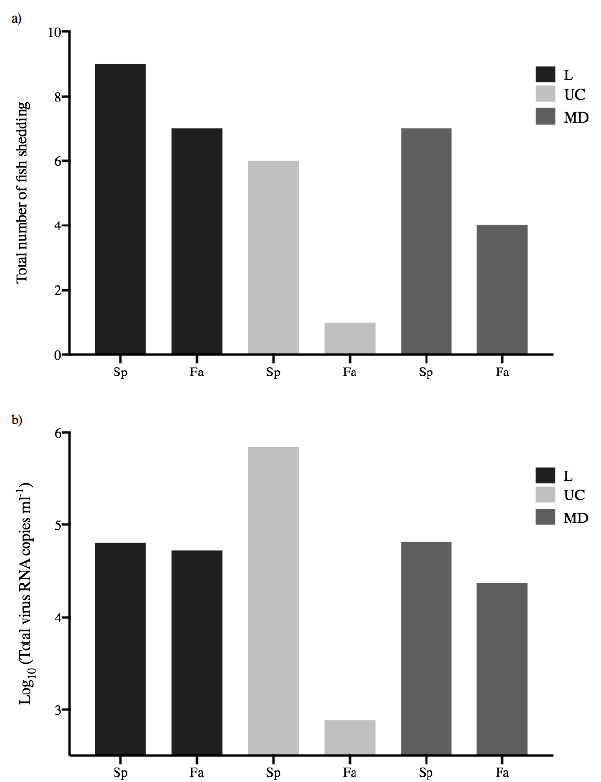
Figure 6. Population-based transmission potential of each treatment group. ( a ) Total number of spring- (Sp) and fall-run (Fa) Chinook salmon shedding L, UC and MD IHN virus over the 30-day course of infection. ( b ) Total virus quantity shed by all fish per treatment group.